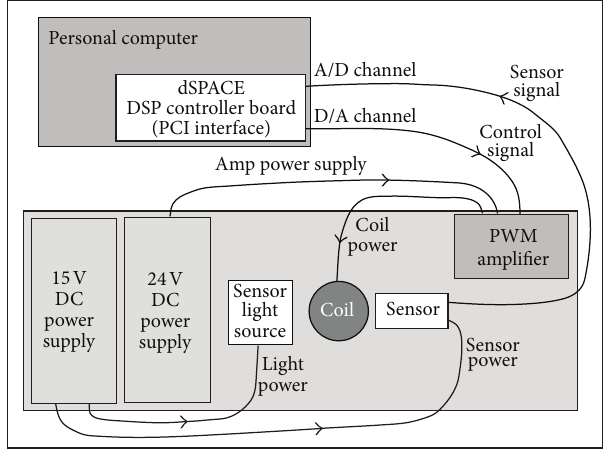
Figure 3: Magnetic levitation system interface diagram.